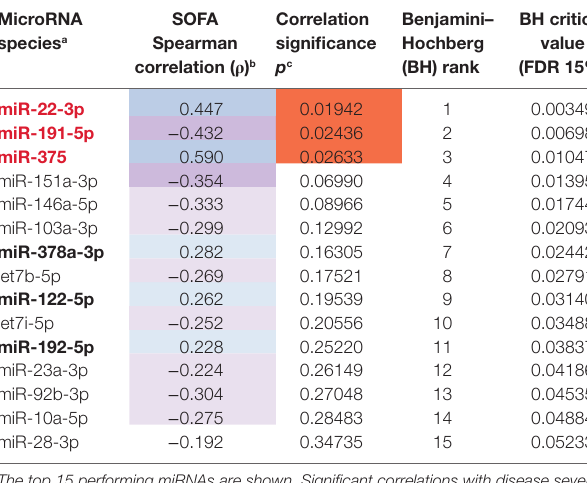
TaBle 4 | Correlations of circulating inflammatory-relevant microRNAs (CIR- miRNAs) with peroxiredoxin-1 levels in non-infective systemic inflammatory response syndrome (SIRS).